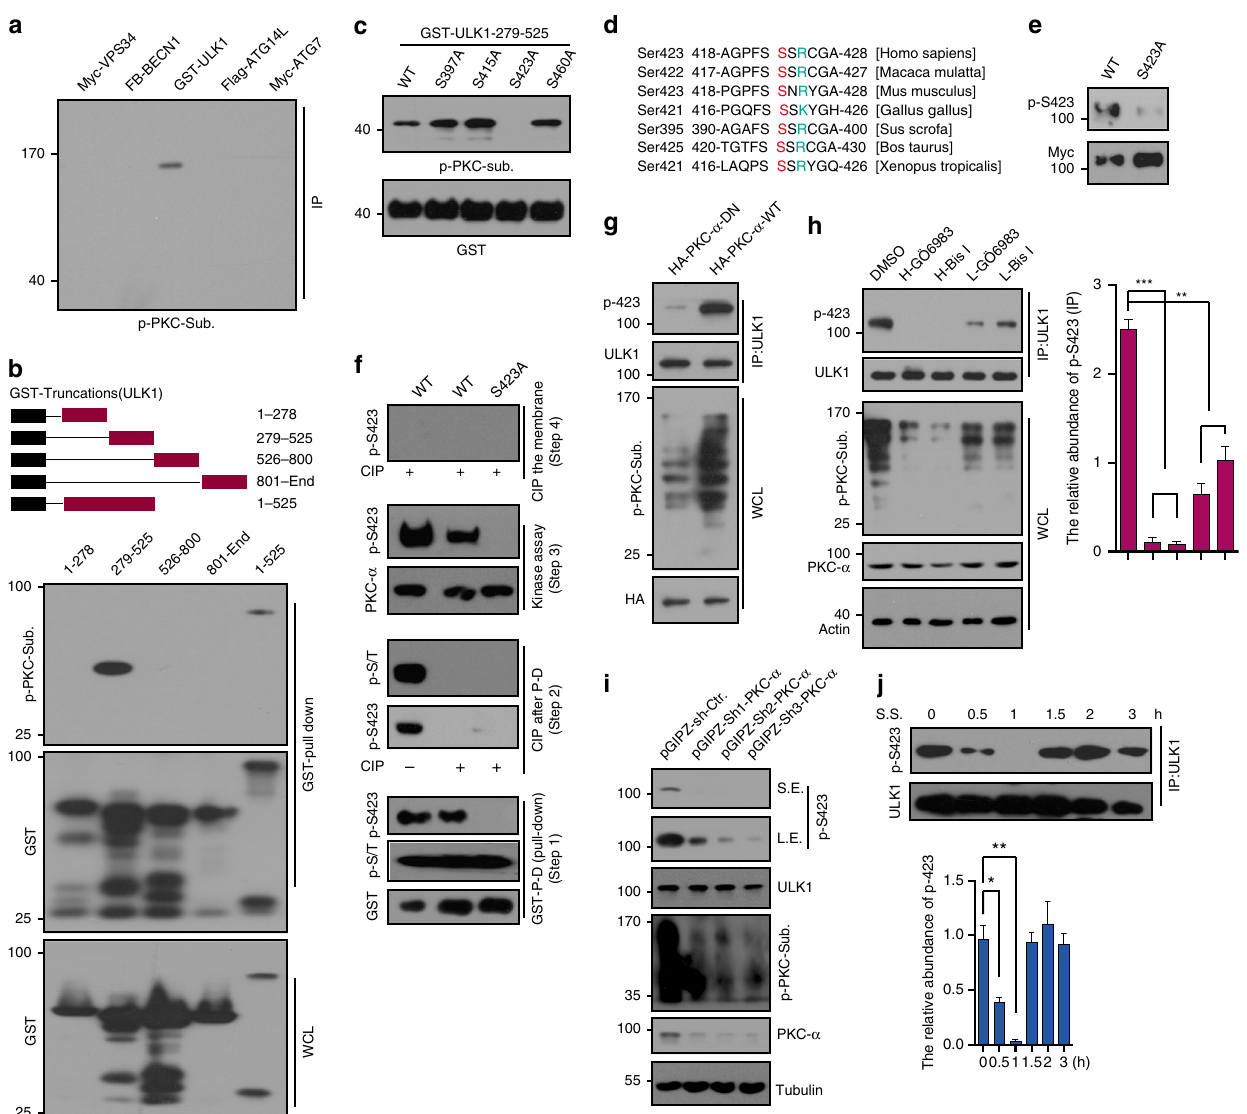
Fig. 1 S423 of ULK1 is the phosphorylation site by PKC α . a Phosphorylation of autophagy-related proteins was detected using p-PKC-Substrate antibody. The expression of these proteins is shown in Supplementary Figure 1a. b GST-ULK1 truncations were transfected and the cell lysates were pulled down for WB analysis with p-PKC-substrate antibody. The phosphorylation site is between 279 – 525AA. c Mapping phosphorylation site of ULK1 by in vitro kinase assay. S423 is the phosphorylation site. d Evolutionary conservation of the ULK1 Ser423. e We generated a p-S423 antibody by ABclonal Technology, and veri fi ed the p-S423 antibody by WB. f Phosphorylation site was con fi rmed by in vitro kinase assay with full-length ULK1. The indicated GST-ULK1s were transfected into HEK293T cells, followed by GST pull down (Step1), Dephosphorylation of the indicated beads by CIP (Step2), PKC α kinase assay (Step3), and CIP treated the whole PVDF membrane to con fi rm the phosphorylation (Step4). g The phosphorylation of endogenous ULK1 was detected by p-S423 antibody after HEK293T cells were transfected with PKC α WT or DN (dominant negative). h p-ULK1 S423 was analyzed by WB after U87 cells were treated with PKC inhibitors GÖ6983 or Bis I for 0.5 h. p-PKC-substrate antibody was used to determine the ef fi ciency of drugs. Actin, ULK1, and PKC α were used as loading controls. The relative abundance of p-S423 was quanti fi ed and shown in the right panel. i U87 cells were infected with lentivirus of